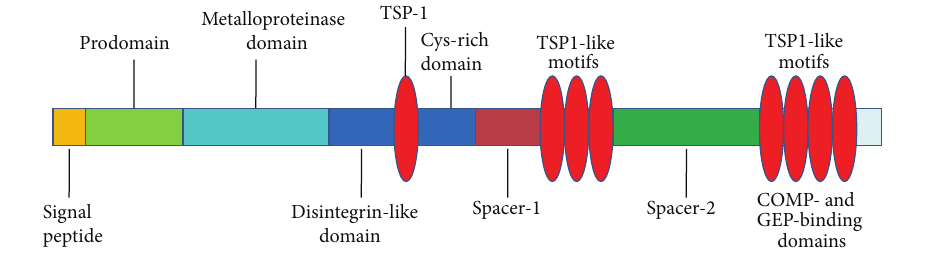
Figure 1: Domain structure and organization of ADAMTS-7. Table 1: Biological characteristics of ADAMTS family